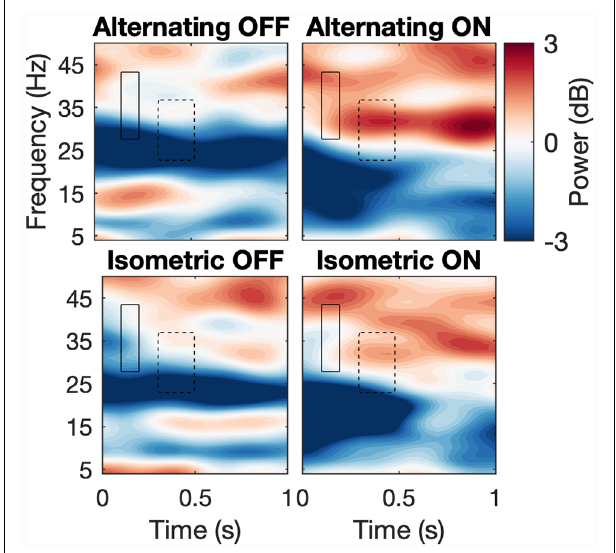
FIGURE 4 | Spectrograms across conditions. Average spectrograms across subjects depicting first second after movement onset for each condition with ROIs. Hard line and dashed line correspond to high beta 1 and 2,